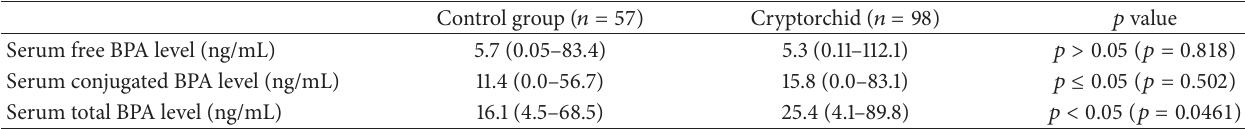
Table 1: Serum BPA level in cryptorchid and control group.